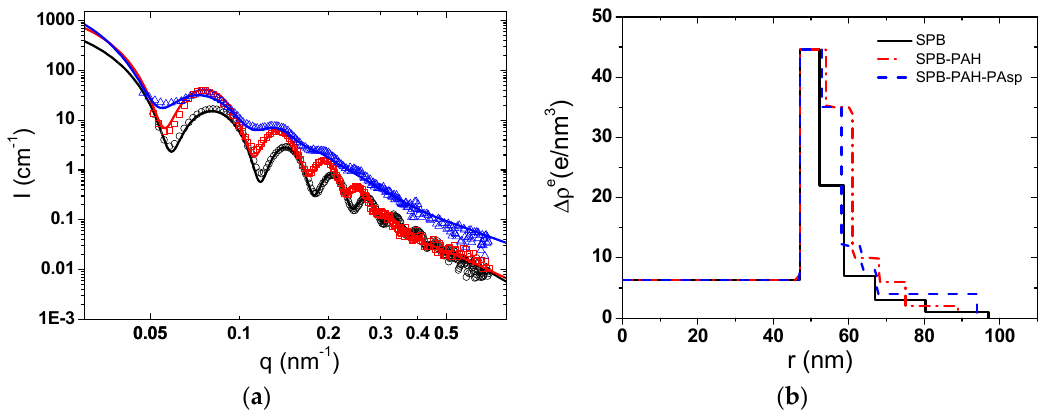
Figure 5. ( a ) Scattering intensity of SPBs ( ○ , black), PAA-PAH double-layers ( □ , red) and PAA-PAH-PAsp triple-layers ( ∆ , blue). The solid line is the fitting curve; ( b ) The radial profile of the excess electron density of multilayer modified SPBs as a function of the radius. (C NaCl = 10 mM, pH = 7). All the SAXS curves were normalized to the same mass fraction of the SPB solution.